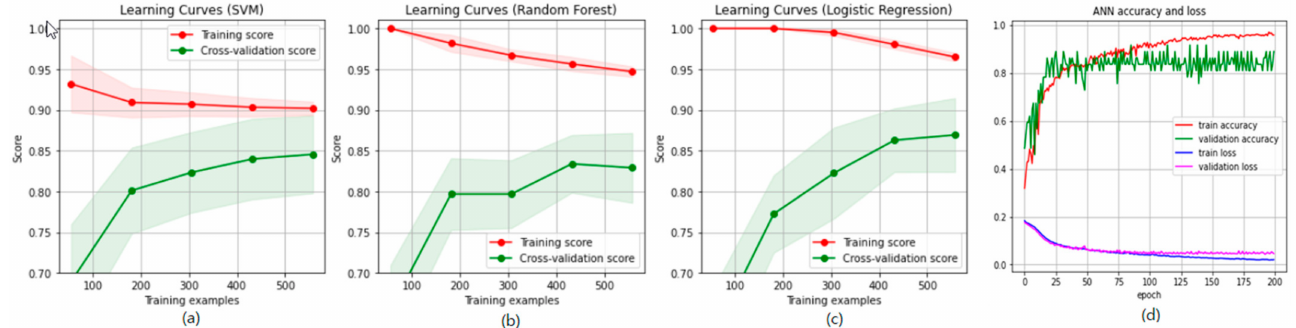
Figure 2. Learning curve of models on the train set and cross-validation. ( a ) is associated with the learning curve of SVM, ( b ) is associated with RF, ( c ) is associated with LR and ( d ) is associated with